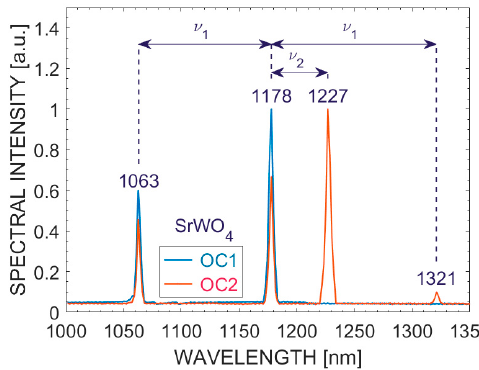
Figure 5. Output SRS radiation spectra for a long (3.6 cm) SrWO 4 crystal.